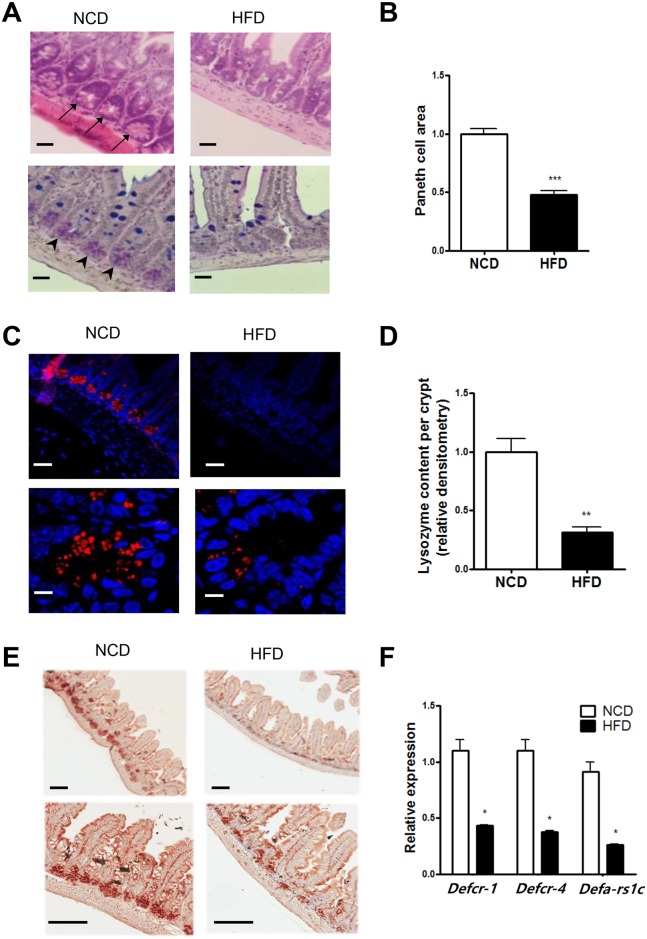
Decrease of Paneth cells in mice fed a high-fat diet (HFD).(A) Hematoxylin and eosin (H&E) staining of the small intestine showing typical eosinophilic granules of Paneth cells at the base of the crypts (upper row, arrows), and a Periodic acid-Schiff (PAS)/Alcian blue-stained section showing purple Paneth cell granules (lower row, arrow heads). Mice were fed either a normal chow diet (NCD) or a HFD for 15 weeks. (B) Quantification of the Paneth cell area was conducted as described in the Materials and methods (n = 5 each). (C) Confocal microscopic images of Paneth cells at the base of the crypts stained with anti-lysozyme Ab. (D) Quantification of lysozyme content per crypt was performed as described in the Materials and methods (n = 5 each). (E) Immunohistochemistry using anti-procryptdin Ab. (F) RT-qPCR analysis of antimicrobial peptides (AMPs) produced at the bottom of the crypts was performed using RNA isolated by laser capture microdissection (n = 5 each). Original magnification for all images is ×100, except the bottom row of (C) (×1,000) and the bottom row of (E) (×200). Scale bar, 100 μm. All values are expressed as the means ± SEM. A student’s t-test was used to compare values between two groups. *P < 0.05, **P < 0.01, and ***P < 0.001.